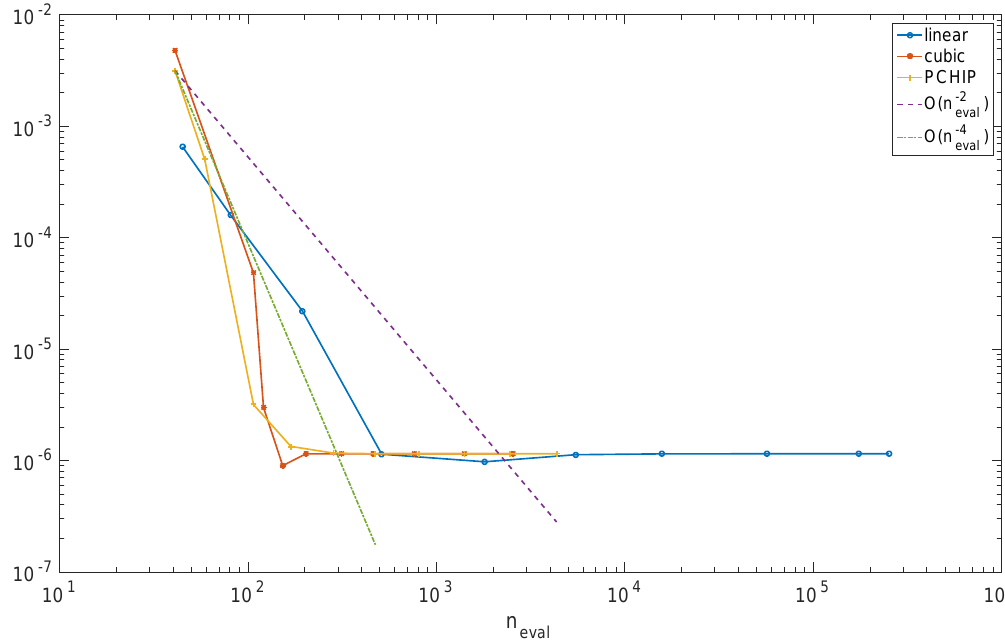
Fig. 6 In continuous line, the graphics of | E − ˆ E 15 | as a function of n eval for ε k = ε varying from 10 − 1 to 10 − 10 , applied to each local rule and f 2 . For comparison, in discontinuous line are shown the growth rates O ( n − 2